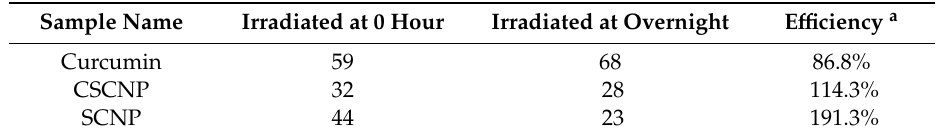
Table 4. Comparisons of DPPH scavenging EC 50 of curcumin, SCNP, and CSCNP while with and without UV irradiation ( µ g /